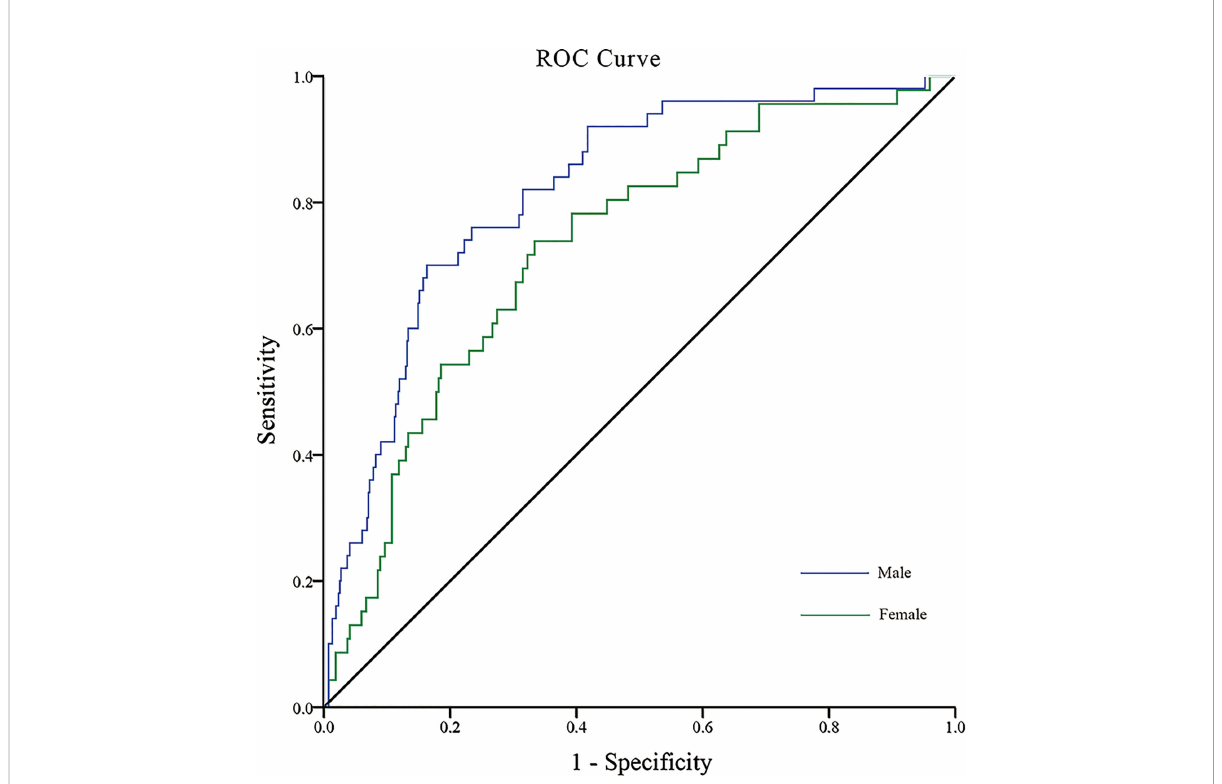
FIGURE 1 ROC analysis of T2DM duration combined with RFCSA and VFA to predict high-/very high-risk prognosis of DKD in male/female T2DM patients. [Male (blue): AUC=0.82; 95% CI: 0.78 – 0.88; Sensitivity 78.0%, Speci fi city 68.6%; P < 0.001] [Female (green): AUC=0.73; 95% CI: 0.66 – 0.81; Sensitivity 73.9%, Speci fi city 63.3%, P <